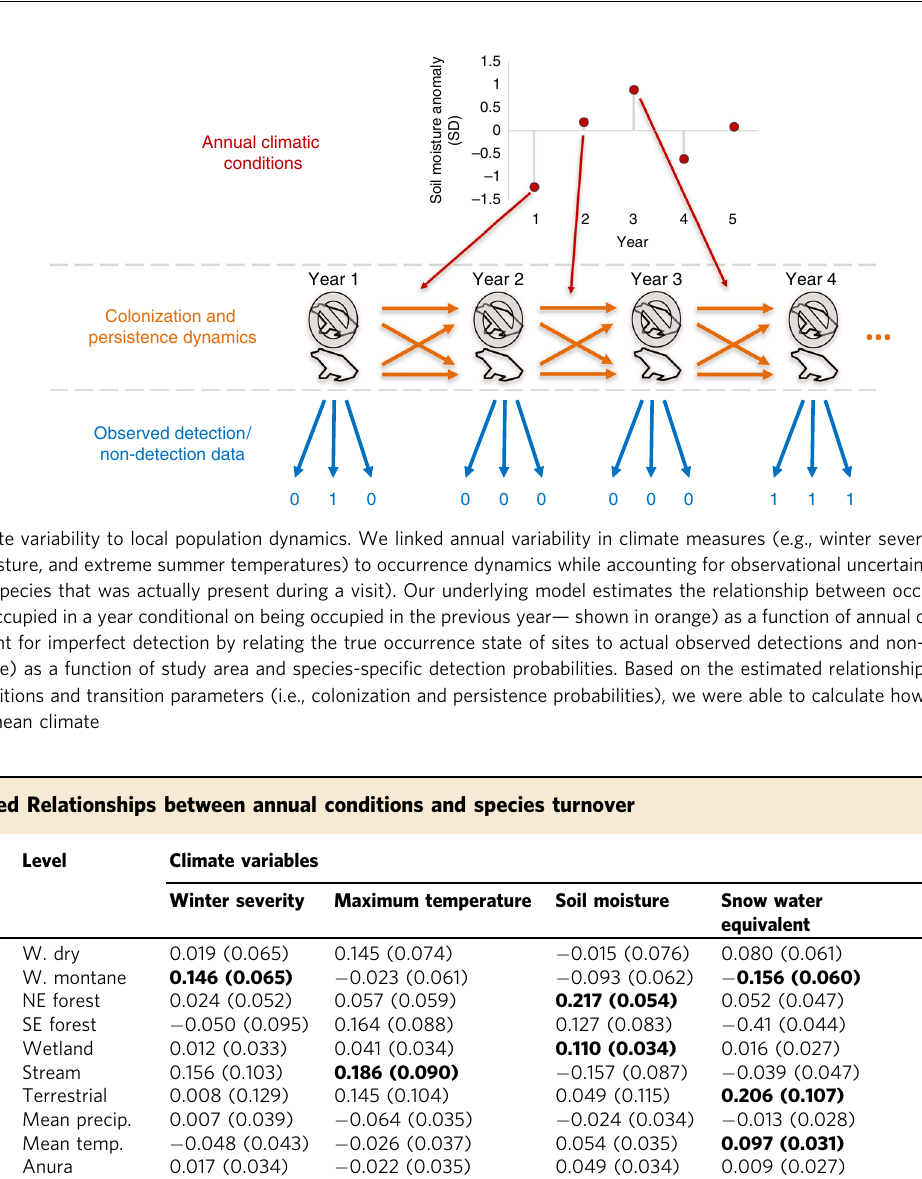
We estimated the relationship between annual conditions for fi ve climatic drivers and species turnover, and how it varies among regions and with respect to long-term climate normals, habitat, taxonomicgroupings,and speciestraits. Effectsizeisona logisticscaleandrepresentsthe effectof a1 SDchangeinthe climatecovariate oncolonizationand persistence.Precisionof estimatesis given bythestandarddeviationoftheposteriorandisshowninparentheses.Positivevaluesareassociatedwithhighercolonizationandpersistencevaluesafteryearswheretheclimatevariablewasabovethe long-term mean. For example, we found a positive effect of more severe winters on colonization and persistence in western montane sites. Thus, we would expect local species richness to decline in response to warming winters due to decreased occupancy. Relationships are also plotted in Fig. 3. Note : Effect sizes that did not include 0 in the 95% credible interval (CI) are denoted in bold.